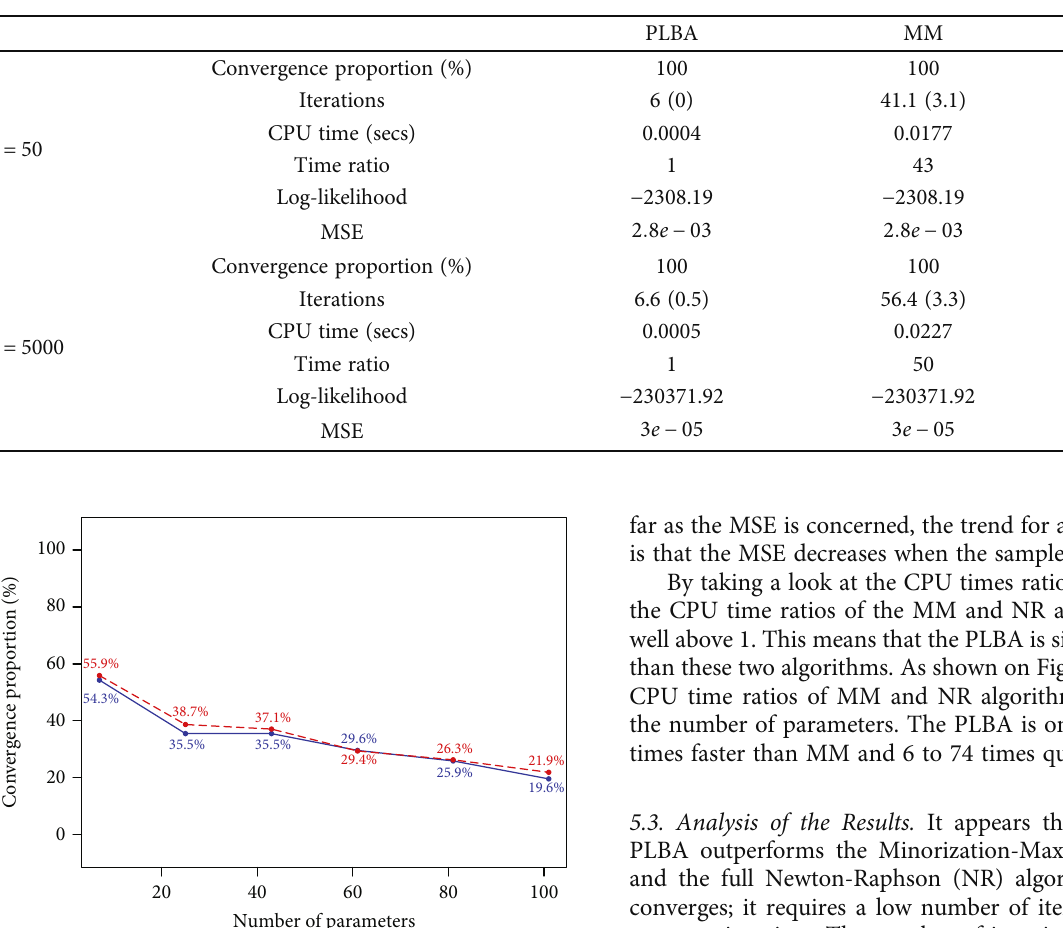
Table 7: Results for Scenario 6 (values in brackets are standard deviations).